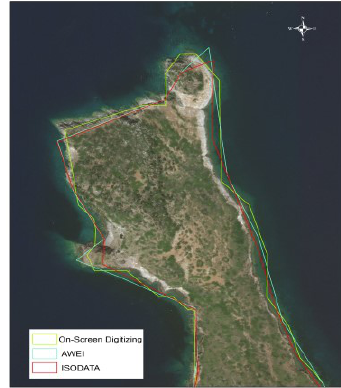
Figure 3. Visualisation of three methods